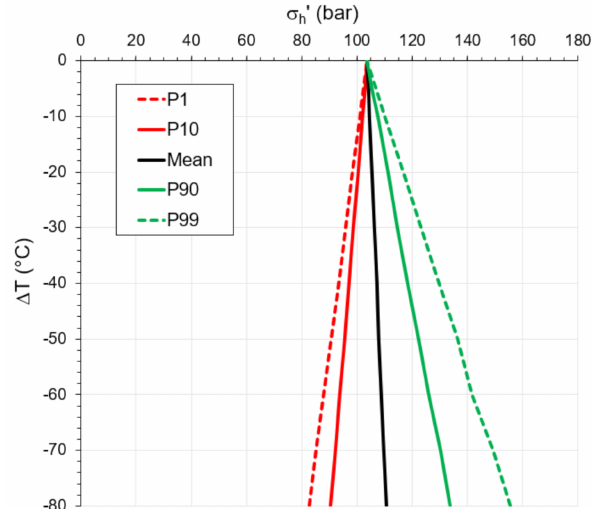
Figure 4. Effective horizontal stress ( σ (cid:48) ) in the shale caprock from cooling with an undrained response. h Results from Monte Carlo simulation for given different temperature